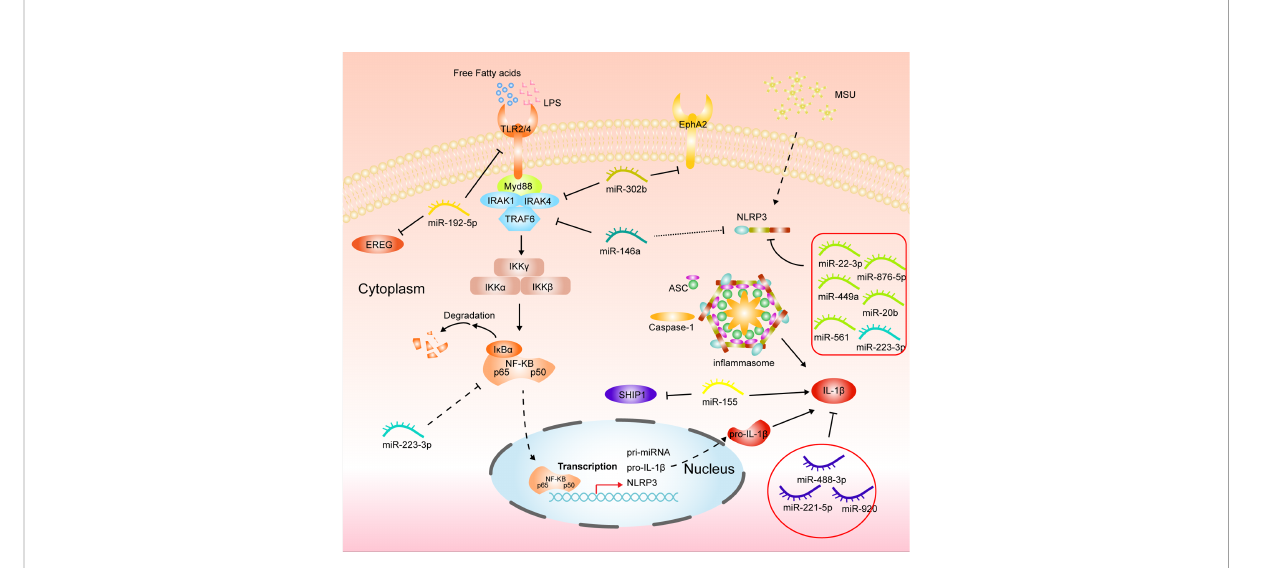
FIGURE 2 Mechanisms of miRNAs in gouty arthritis regulating in fl ammatory pathways in